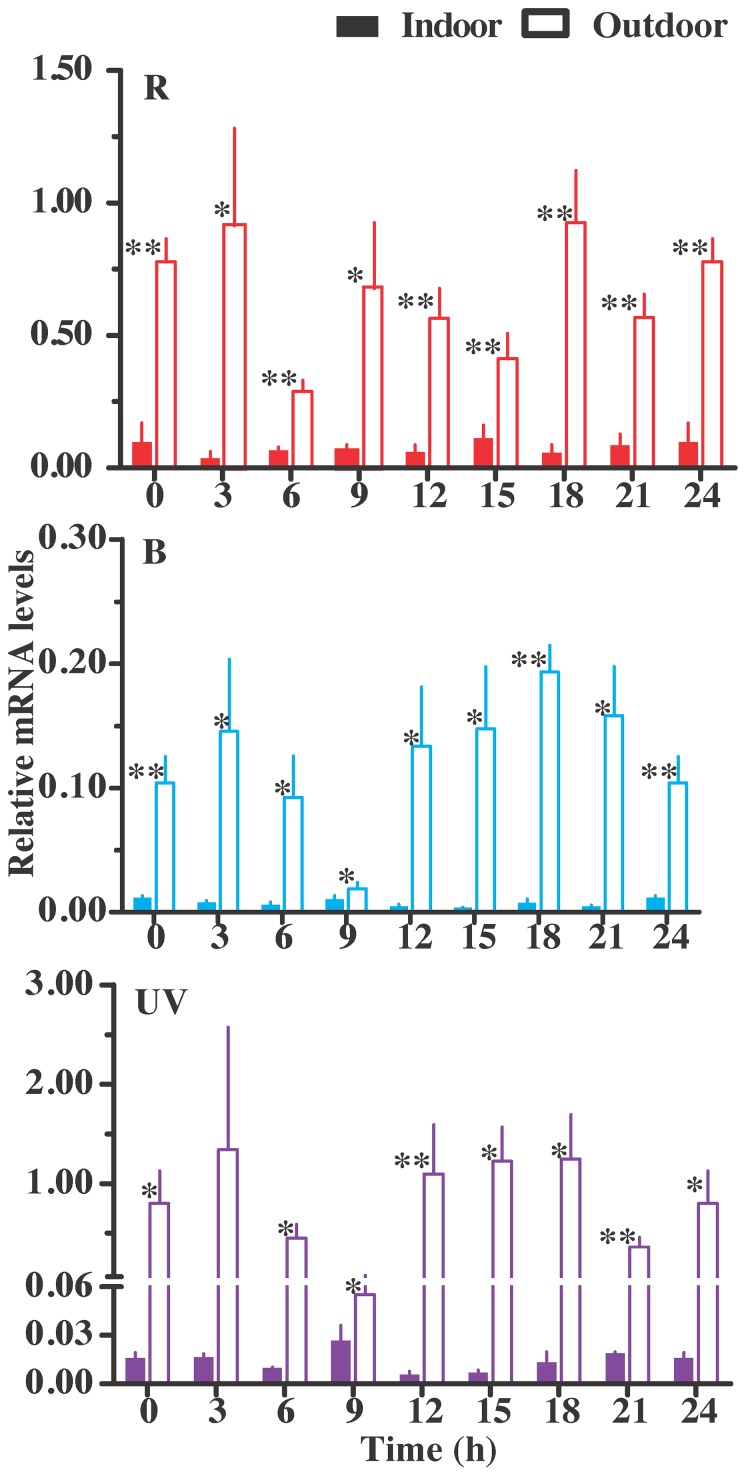
Relative expression level of R, B and UV opsins between indoor and outdoor Helicoverpa armigera.Mean ± SE. “Indoor” stands for lab-reared individuals, n = 4 for each point. “Outdoor” stands for the wild-captured individuals, n = 4 for each point except for UV at 3∶00 (n = 3) and 21∶00 (n = 2). The “*” and “**” denote statistical significance of the expression levels at P<0.05 and P<0.01, respectively.